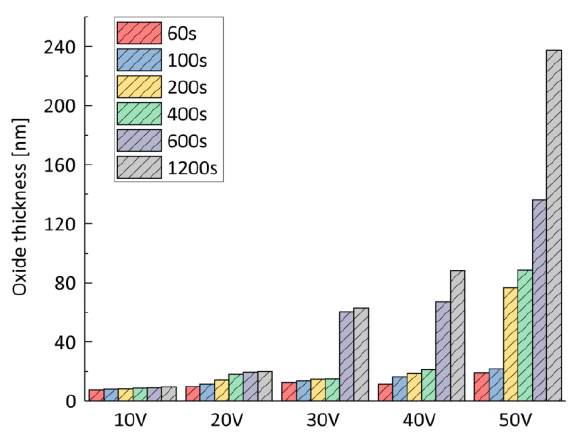
Figure 7. Oxide film thickness obtained from the ellipsometric parameters.